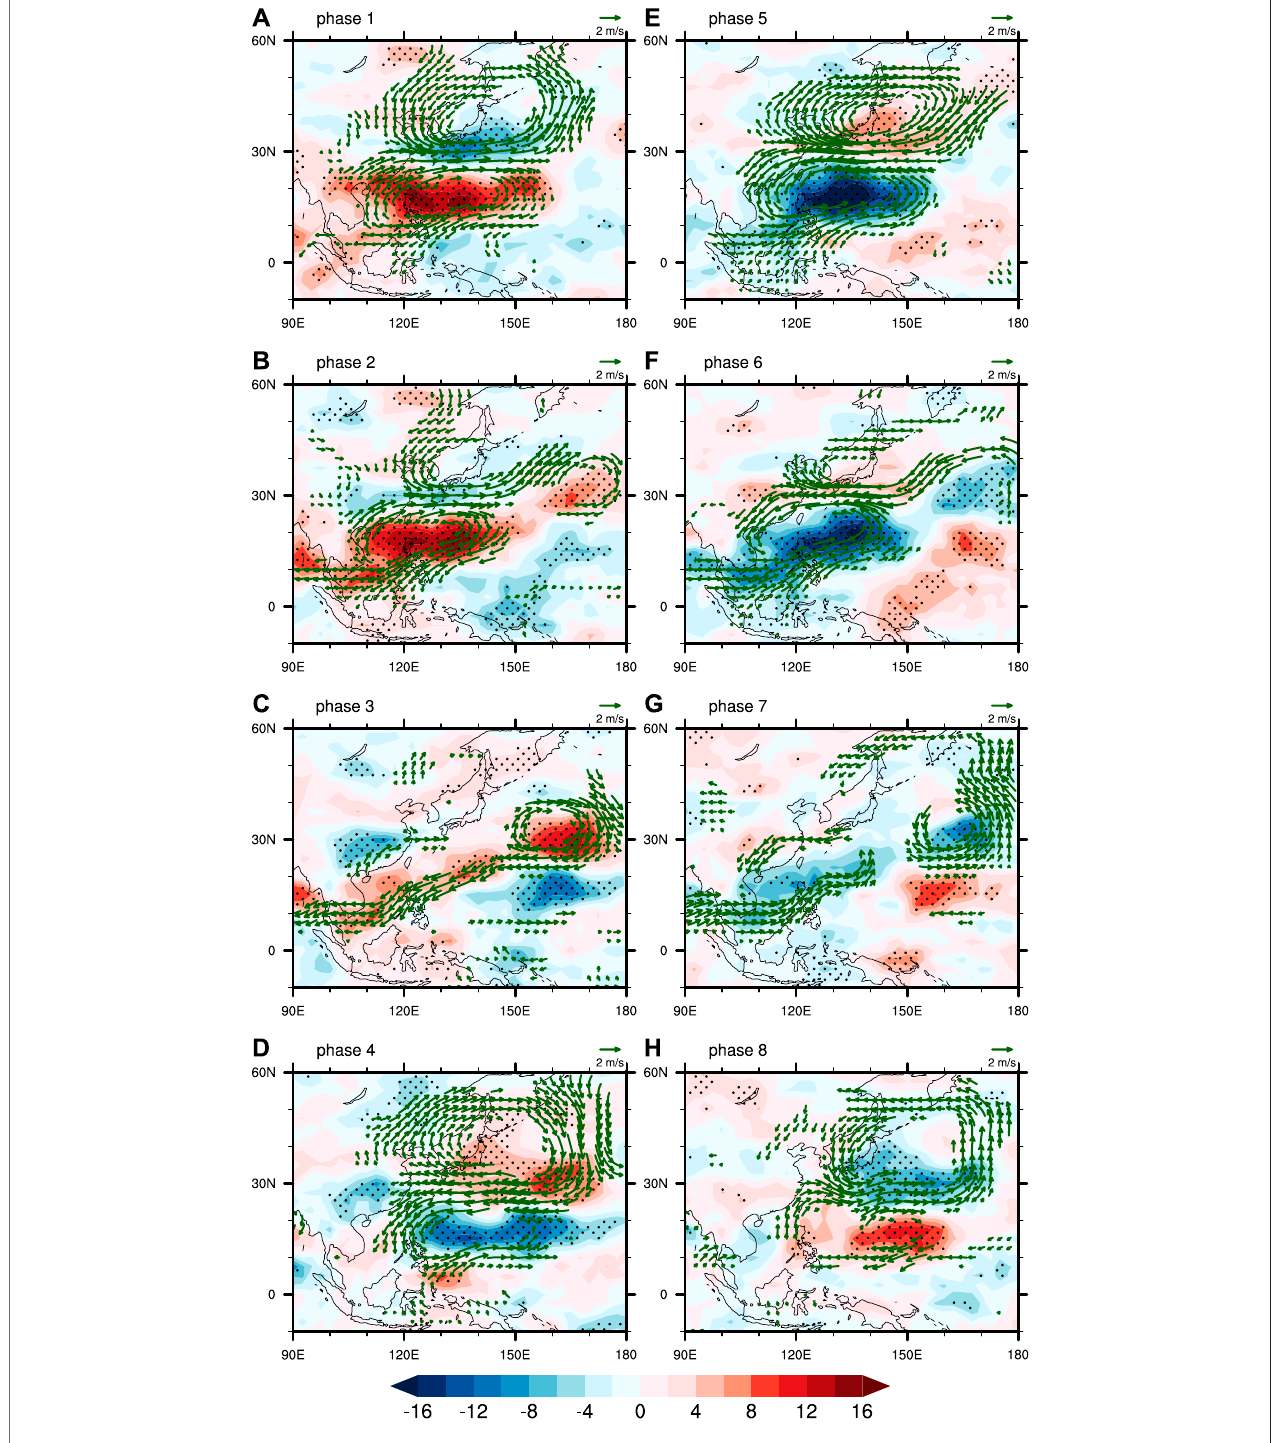
FIGURE 9 | The composite 10 – 30 days fi ltered OLR (shadings, unit: W/m 2 ) and 850 hPa wind (vectors, unit: m/s) at 8 phases of WPSH_SMI_10-30d . The dotted Shadings and vectors are statistically signi fi cant at 0.05 level.